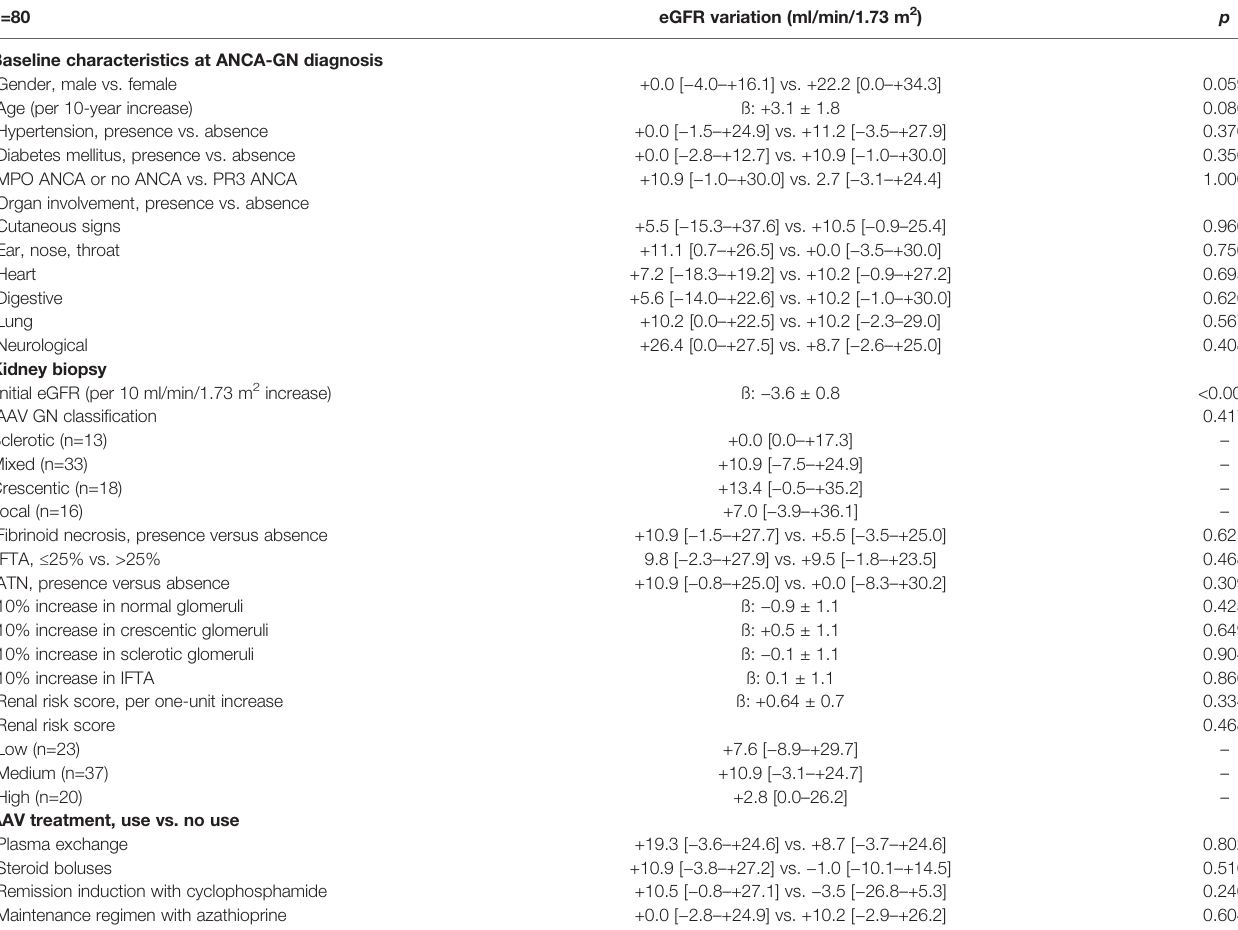
TABLE 2 | Univariable analysis of factors associated with eGFR variation between ANCA-GN diagnosis and month 24 in the eGFR cohort. n=80 Baseline characteristics at ANCA-GN diagnosis Gender, male vs.